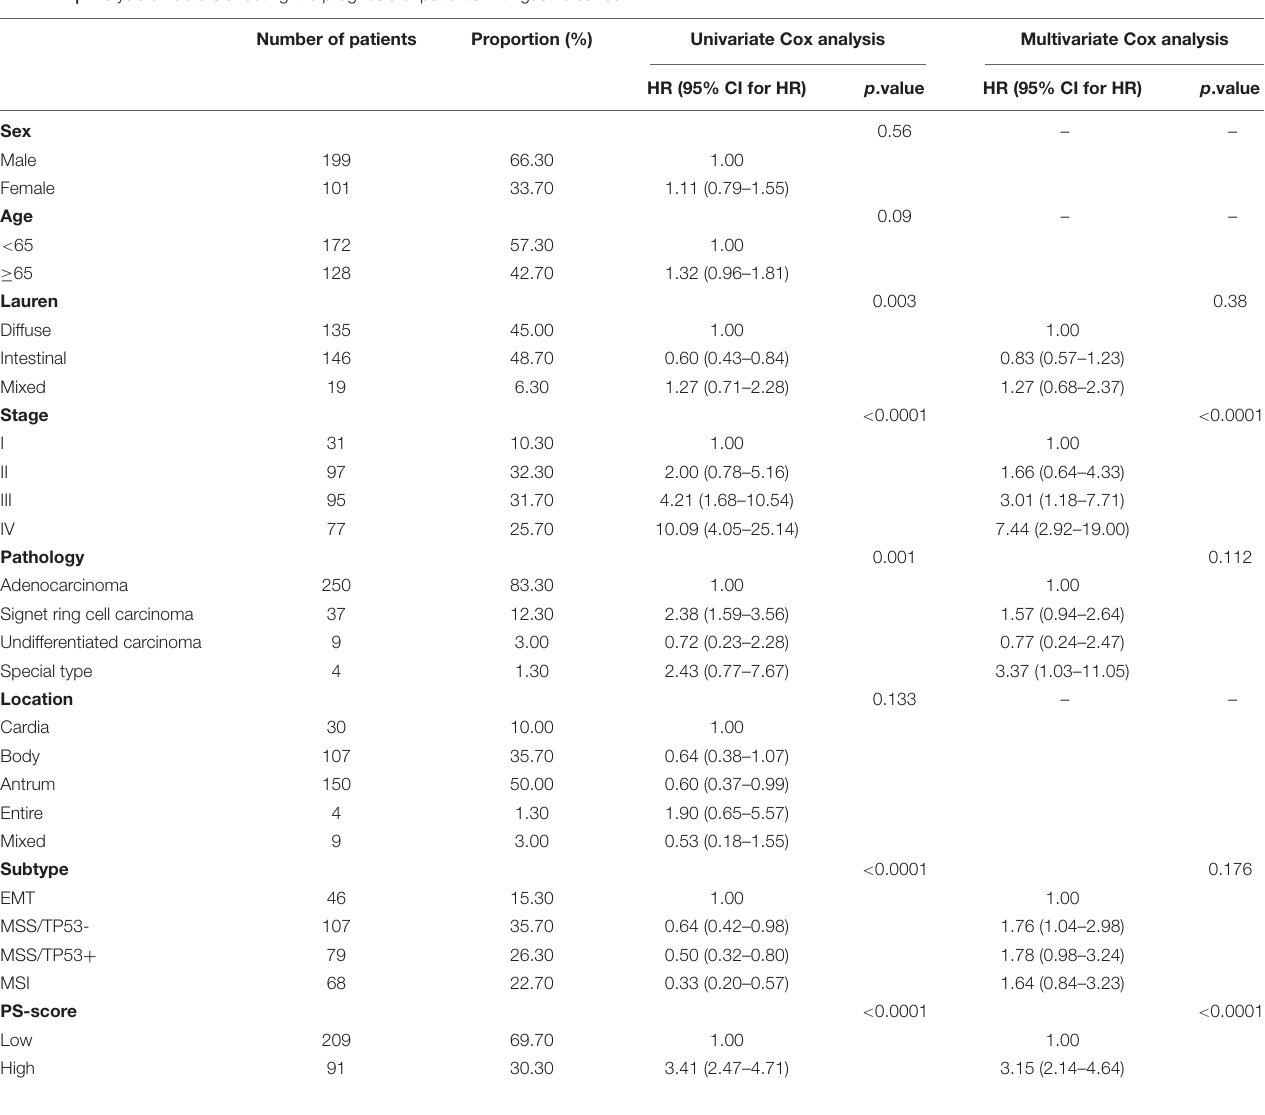
TABLE 2 | Analysis of factors affecting the prognosis of patients with gastric